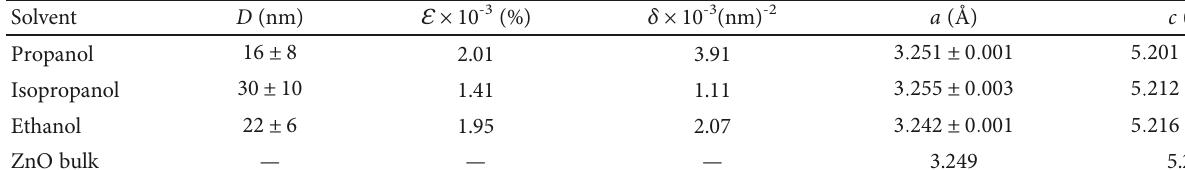
Table 1: Evaluated structural parameters of ZnO thin fi lms compared with the bulk ones.